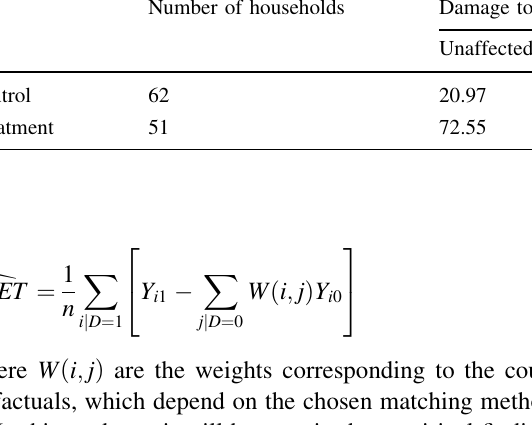
Table 1 Damage to houses, by control and treatment groups, studied in Picsi, Chiclayo Province, Peru´ Number of